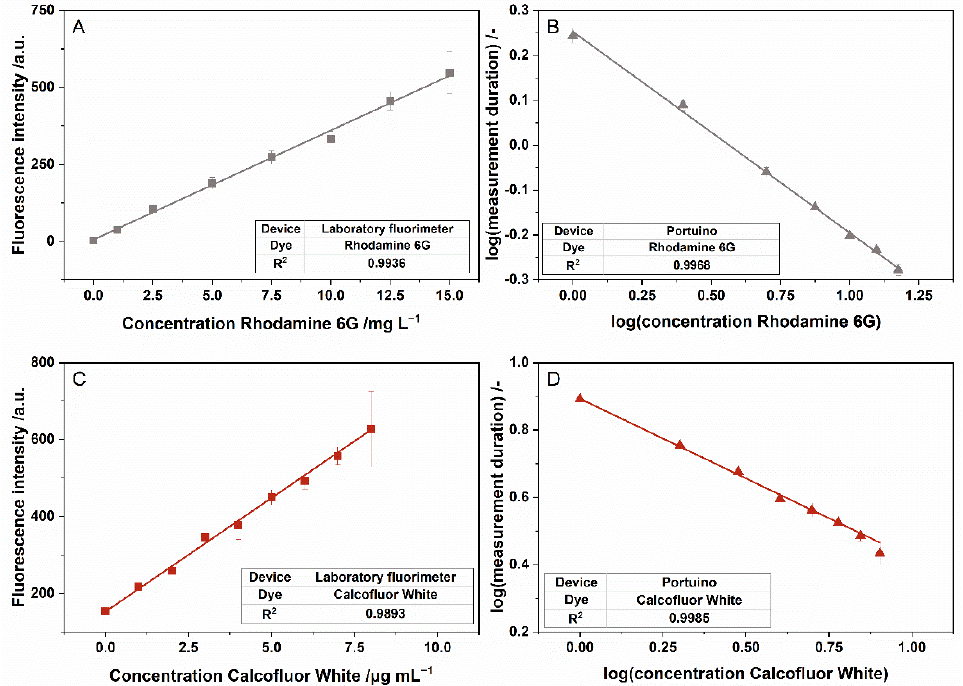
Figure 6. ( A , B ): Response of different devices for fluorescence measurement of calcofluor white. The standards were excited with light with a wavelength of 355 nm. Emitted light was measured with a laboratory fluorimeter ( A ) at a wavelength of 430 nm, and measurement duration was recorded with the Portuino ( B ). Parameter laboratory fluorimeter: Excitation slit = 10, Emission slit = 10, Gain = Low. n = 3; ( C , D ): Response of different devices for fluorescence measurement of calcofluor white. The standards were excited with light with a wavelength of 488 nm using the laboratory fluorimeter and with light of a wavelength of 490 nm using the Portuino. Emitted light was measured with a laboratory fluorimeter ( C ) at a wavelength of 553 nm, and measurement duration was recorded with the Portuino ( D ). Parameter laboratory fluorimeter: Excitation slit = 5, Emission slit = 5, Gain = High. n = 3.